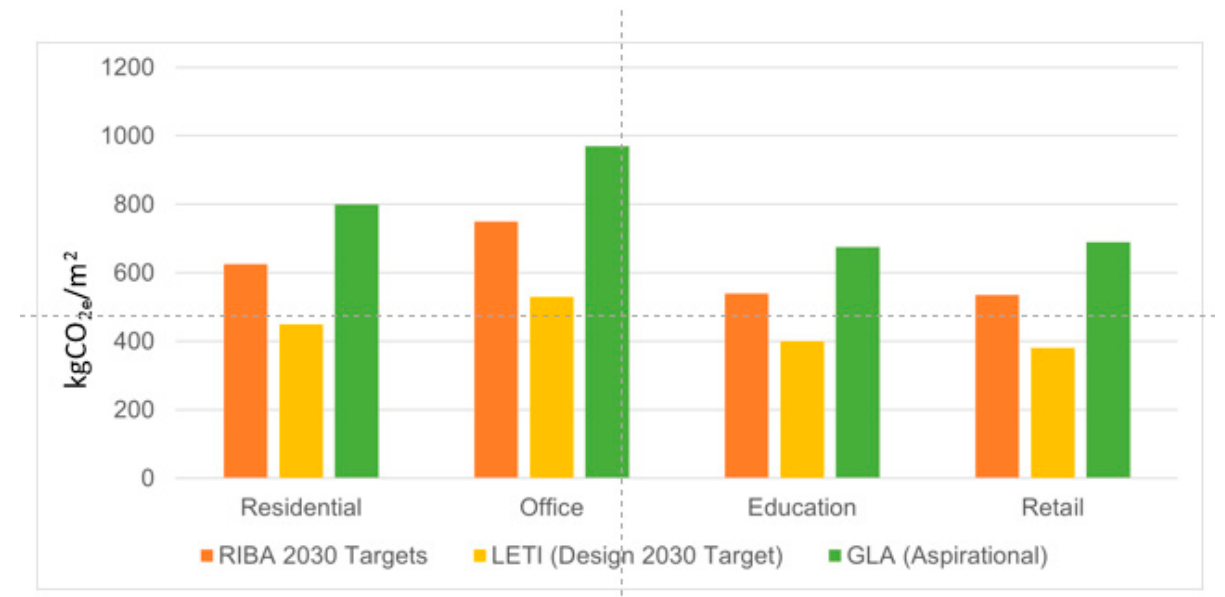
4 of 16 Figure 3. LCA Stages Based on EN 15978:2011. In recent years, the Building Research Establishment Environmental Assessment Method (BREEAM) and the Greater London Authority (GLA) have started to require LCA reporting for building projects. In the BREEAM NC 2018 [16], a building can achieve up to 7 credits under the Materials heading Mat 01—Environmental impacts from construc- tion products—Building life cycle assessment section to receive outstanding or excellence certificates. The GLA requires analysis of pre-planning and post-completion stages of a project with current carbon figures and future decarbonised scenarios. Organisations such as the Royal Institute of British Architects (RIBA), the Low En-